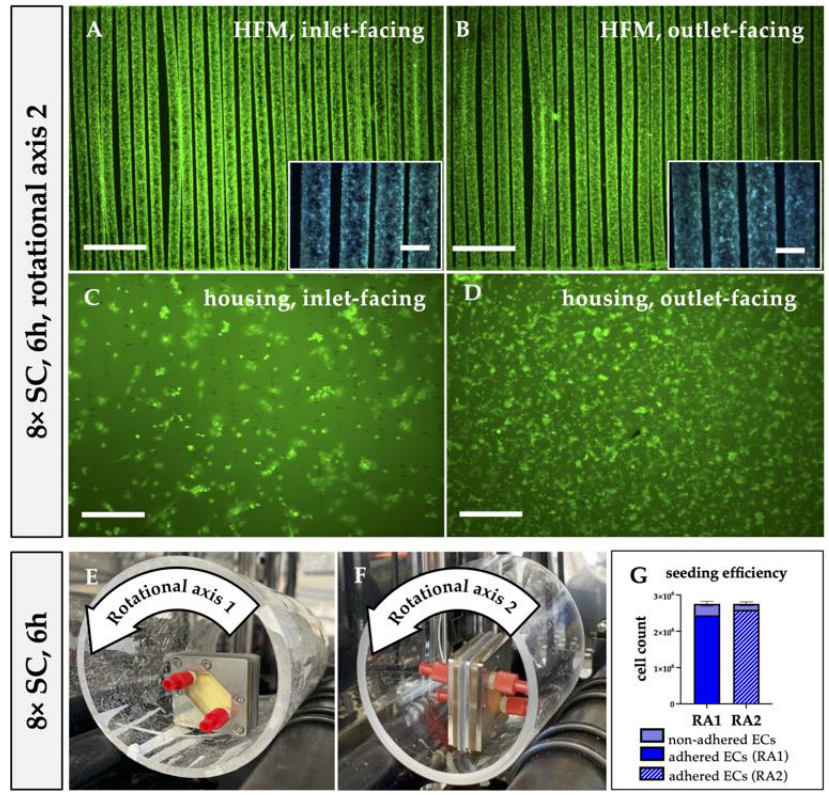
Figure 5. Transversal rotational axis for seeding procedure improved EC distribution. Following the injection of 8 × SC and changing from RA1 ( E ) to RA2 ( F ) for 6 h, fluorescence microscopy images were taken from HFMs ( A , B ) and housing ( C , D ) and facing inlet ( A , C ) and outlet ( B , D ) after staining with calcein (green) and Hoechst 33342 (blue). Scale: 2 mm, insert boxes in A, B, scale: 400 µm. Picture of the oxygenator position on the roller device during RA1 ( E ) and RA2 ( F ), respective silicone stoppers fixing the oxygenator in position were taken out for better visualization. ( G ) Quantification of percent adherent ECs of the complete MOx after incubation with 8 × SC for 6 h under RA1 and RA2. SC: seeding concentration, RA: rotational axis.